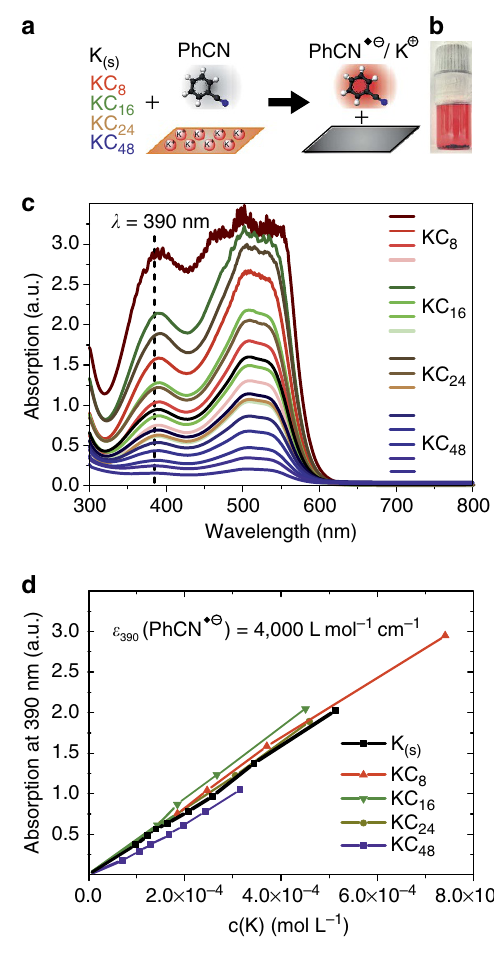
Figure 1 | Charge quantification in GICs using UV/Vis spectroscopy. ( a ) Reaction scheme for the quantitative electron transfer from various GICs to PhCN leading to dissolved K þ ions and the red coloured radical anion PhCN (cid:3) (cid:2) . ( b ) Photograph of a sealed vial containing KC 8 in a concentration of 5.0 (cid:4) 10 (cid:2) 4 M in PhCN (cid:3) (cid:2) . ( c ) Absorption spectra under inert conditions of the dilution series of four different stages of GICs dispersed in PhCN. The resulting absorption profiles correlate to the benzonitrile radical anion PhCN (cid:3) (cid:2) . The dashed line indicates the wavelength used for the determination of e 390. . The exact concentration values—colour coded—are given in Supplementary Table 1. ( d ) Determination of the extinction coefficient by correlation of the potassium concentration versus the extinction at 390nm. The black curve represents the dilution series of pure potassium K (s) in